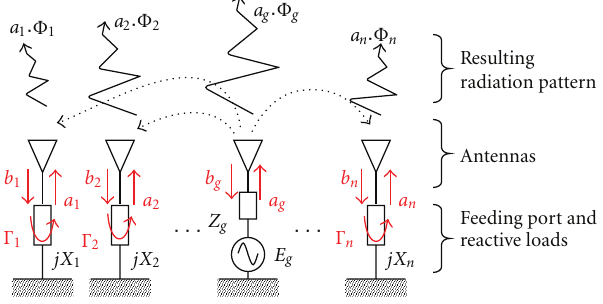
Figure 24: Principle of a parasitic antenna